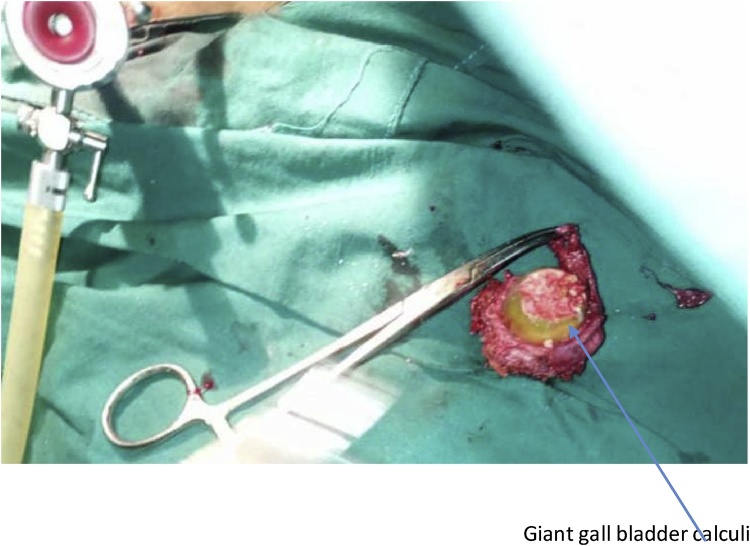
Giant gallstone.